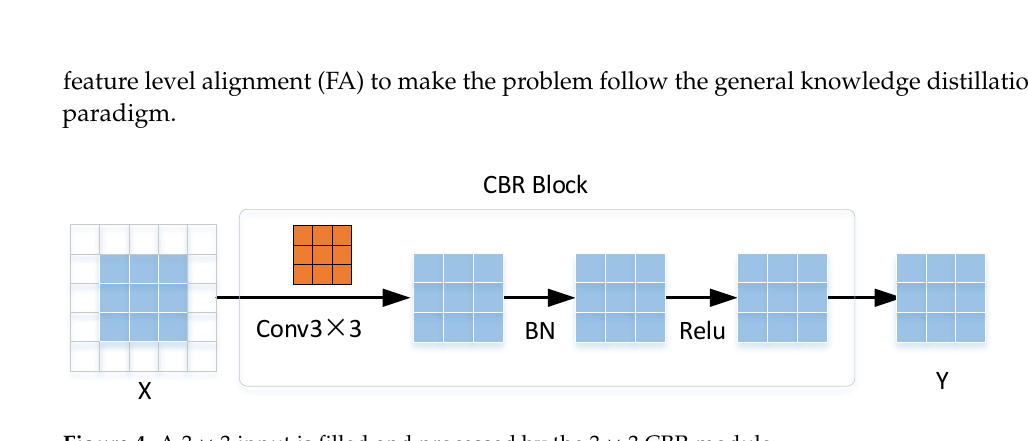
Figure 4. A 3 × 3 input is filled and processed by the 3 × 3 CBR